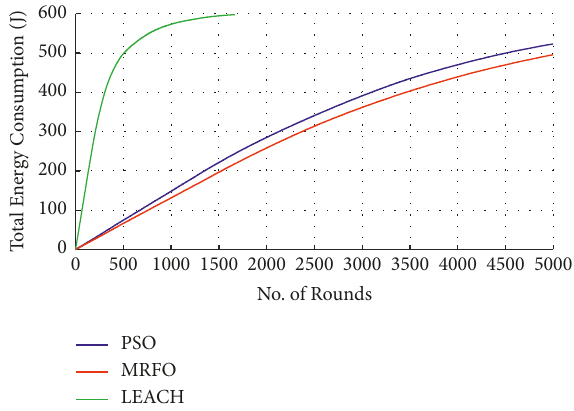
Figure 11: Total energy consumption for 300-node network, 30 CHs when the BS is at the outside the ROI.